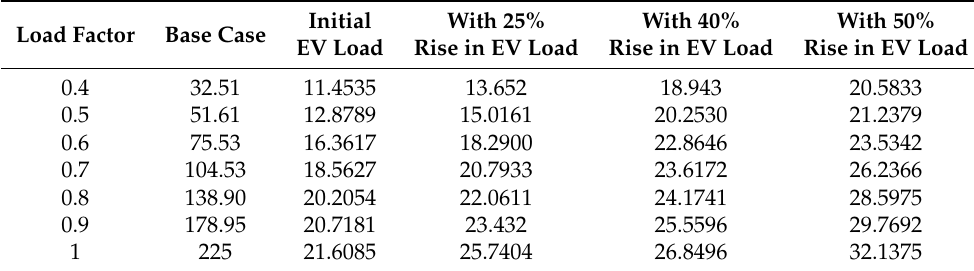
Table 13. Impact on the active power loss (kW) in a 69-bus radial DST.